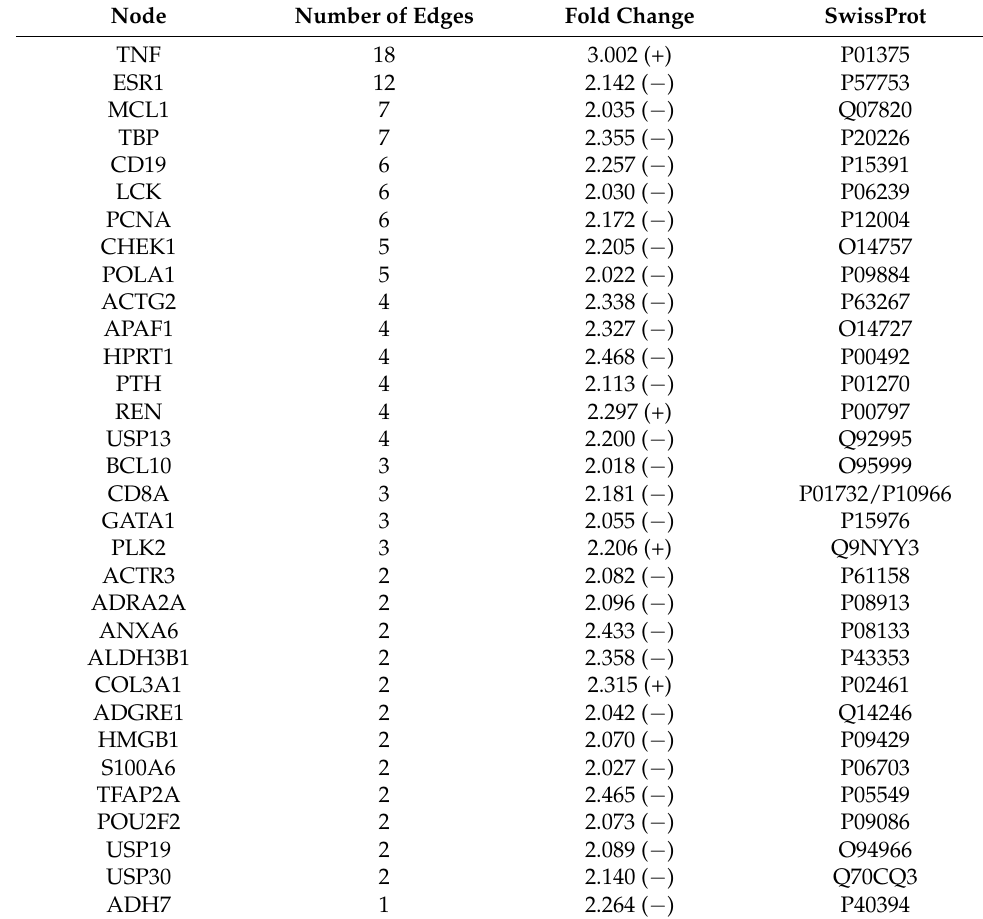
Table 1. Nodes and edges in the PPIs of intracellular proteins up- and down-regulated (>2-fold) in HeLa cells treated with H-CM compared with